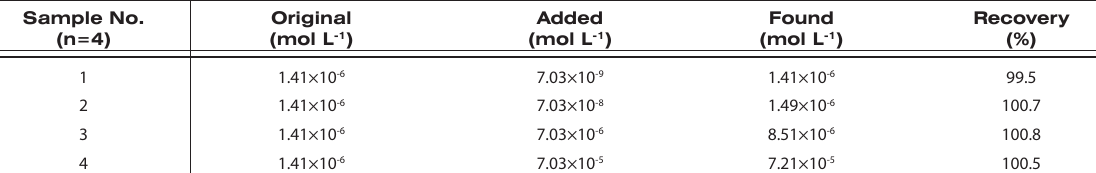
Table 6. The results and recoveries for determining Eu 3+ in artificial water